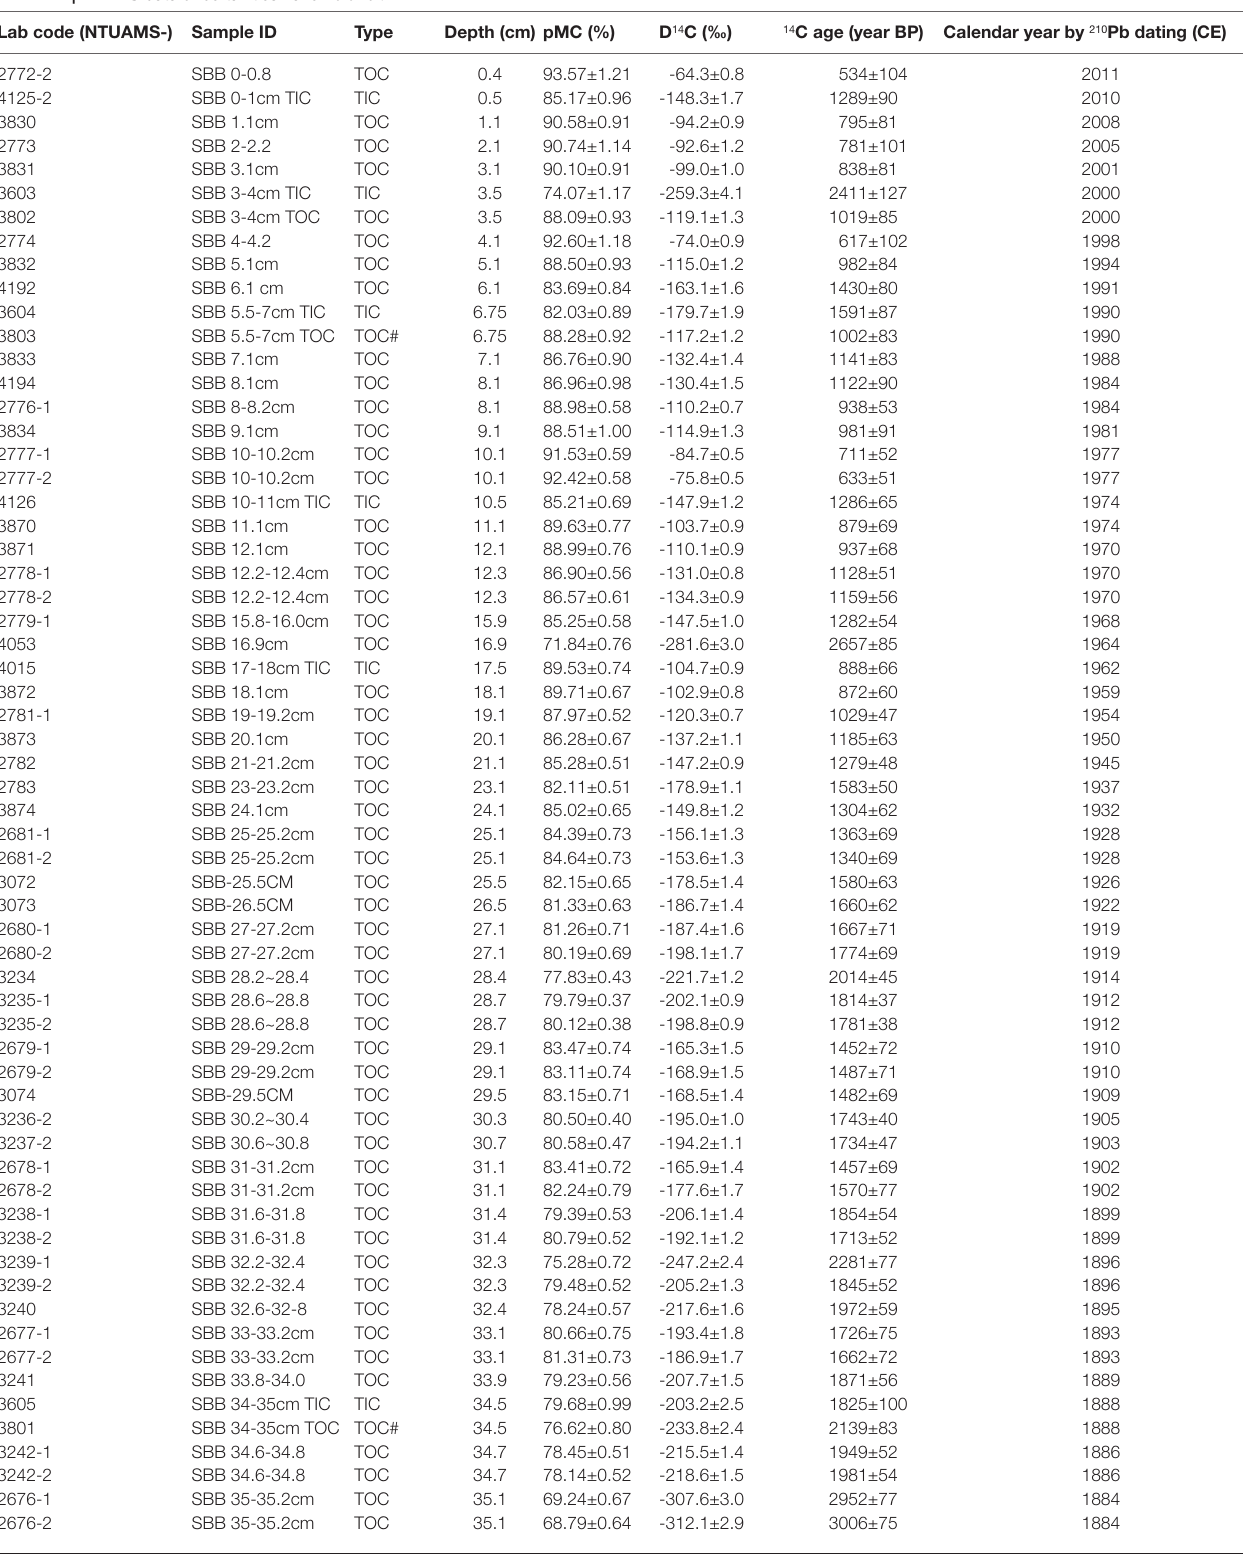
TABLE 2 | All AMS data uncertainties have 2 σ